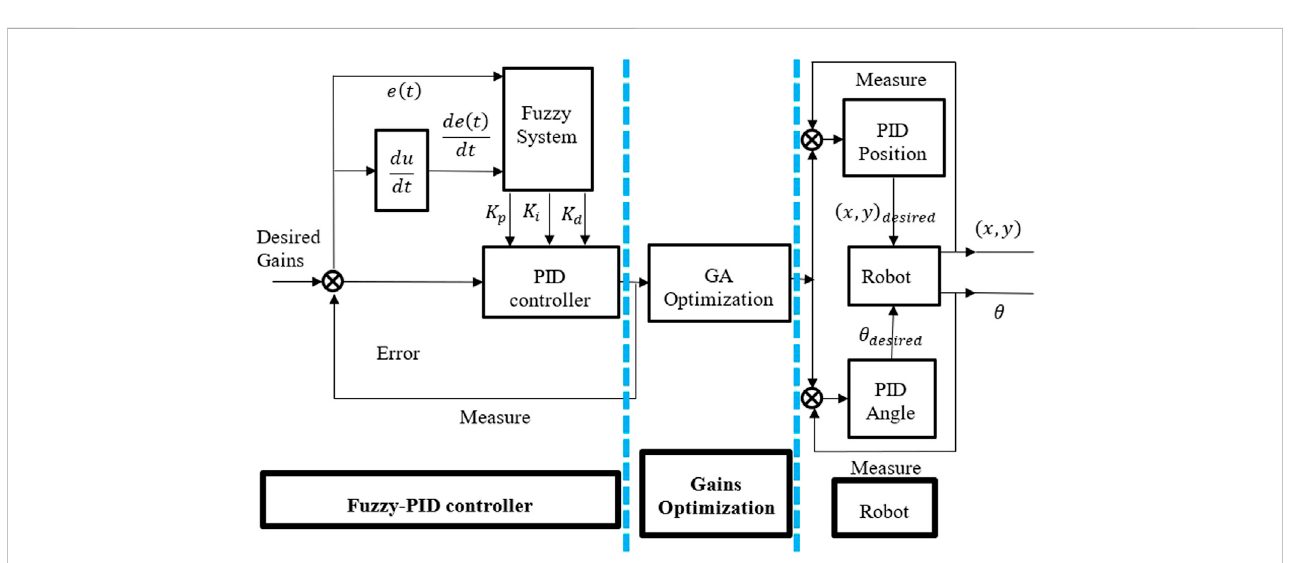
FIGURE 3 Structure of Turtlebot3 with proposed controller, GA optimization and path planning.